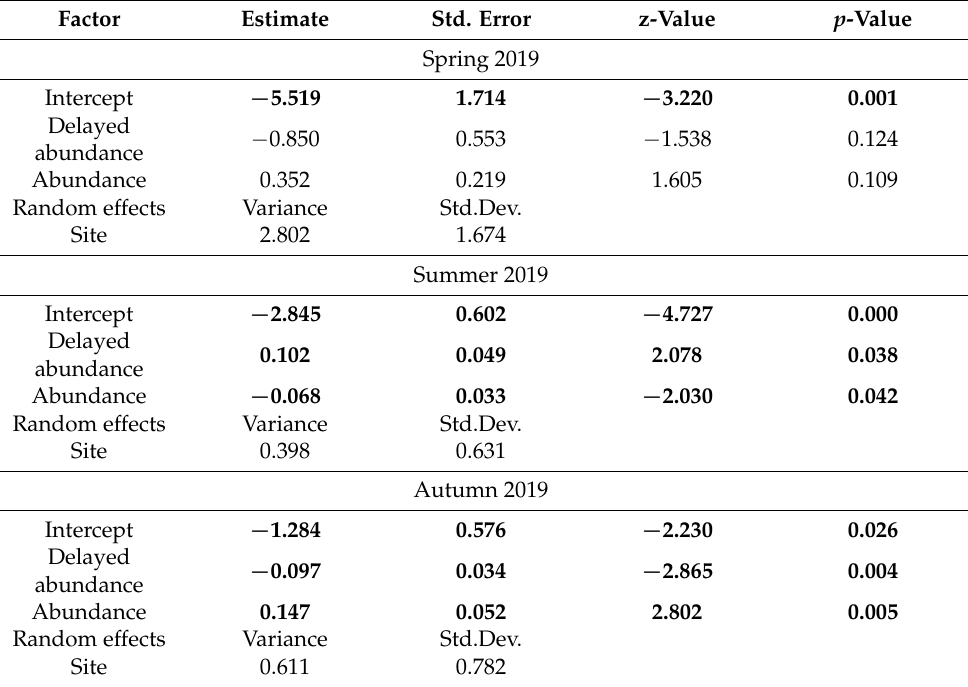
Table 4. Results of generalized linear mixed modelling with binomial error distribution showing the impact of abundance and delayed abundance on individual infection probability for the year 2019. Std.